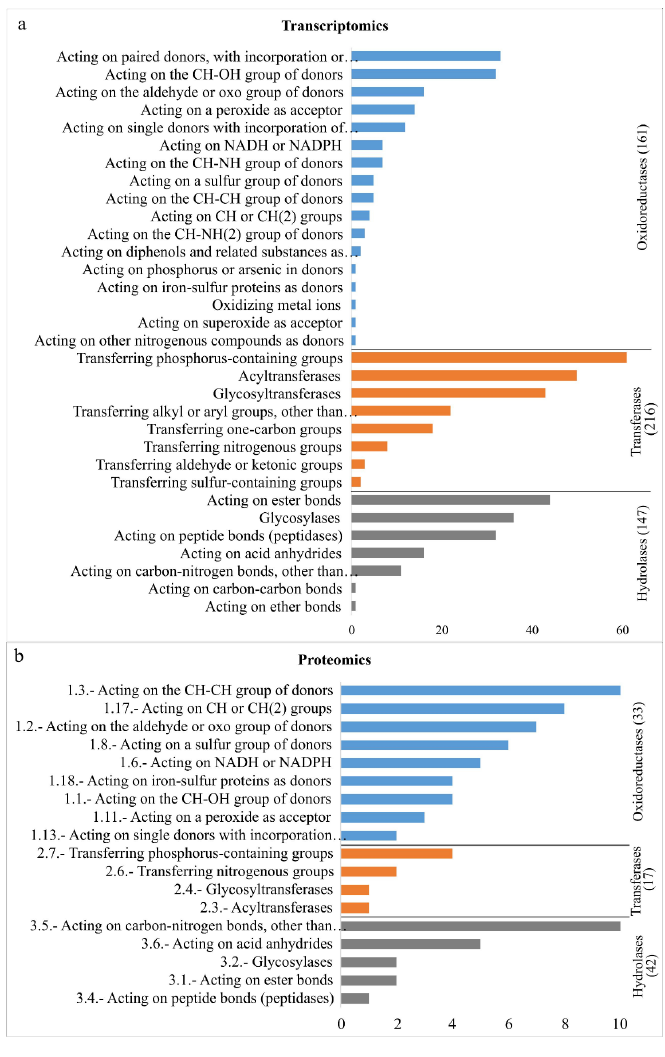
Figure 2. Gene Ontology (GO) annotation classification statistics graph from full-length transcriptome and proteome in the leaves of young oil palm plants under salinity stress; classified accordingly to chemical reactions by which proteins are classified according to E.C. Only the three prevalent classes are shown: oxireductases (EC 1), transferases (EC 2), and hydrolases (EC 3). ( a )—Transcriptomics Single Analysis, and ( b )—Proteomics Single Analysis.